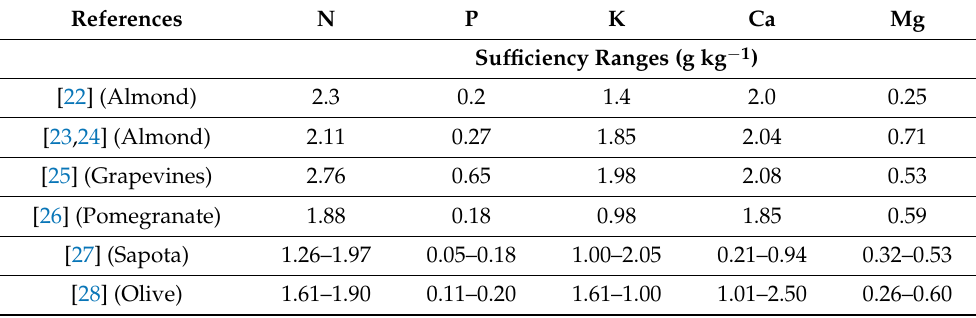
Table 3. Sufficiency ranges for almond and other fruits trees according to other